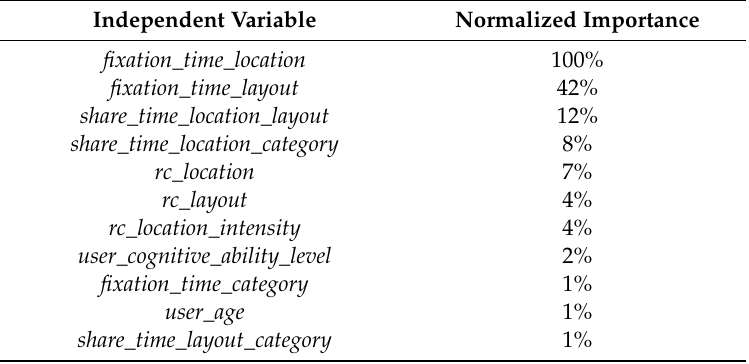
Figure 5. Sensitivity and specificity for the multilayer perceptron. Confusion matrix for multilayer perceptron for predicting the e ffi ciency of the recommending